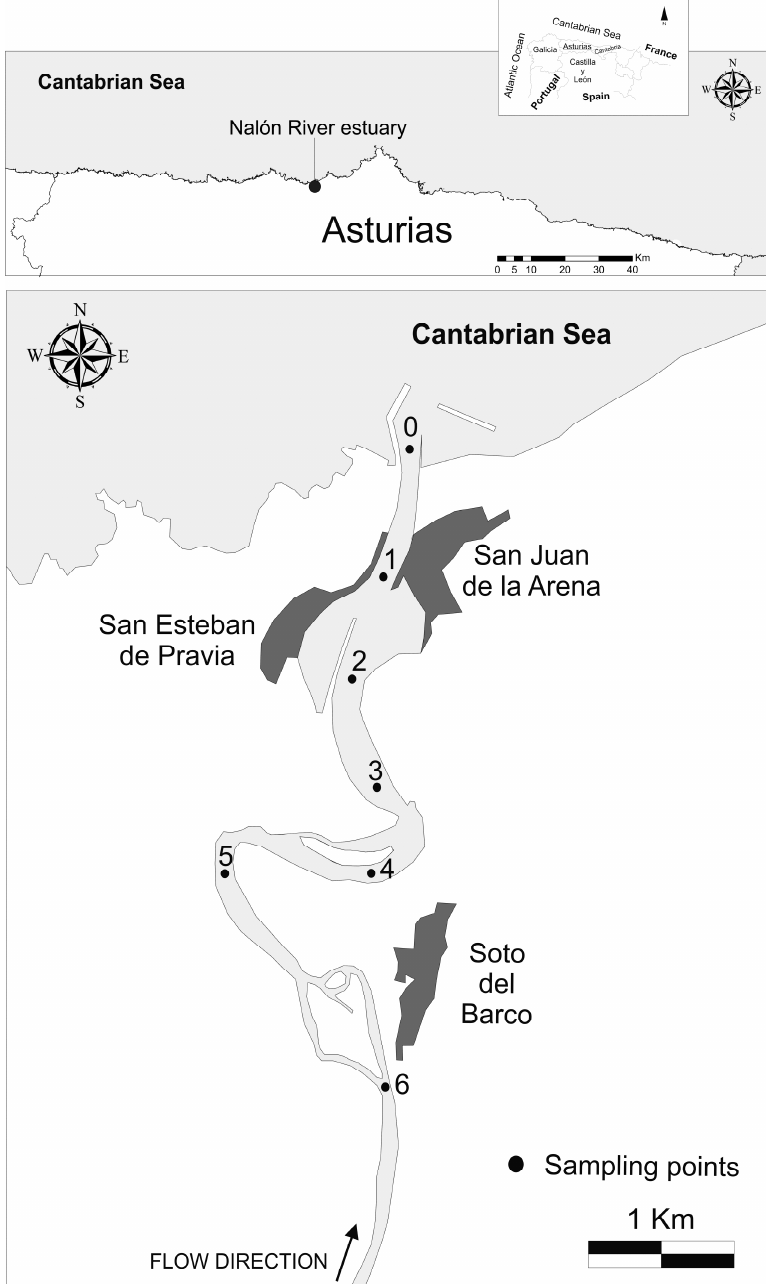
Figure 1. Study area and sampling points along the Nalón River estuary.